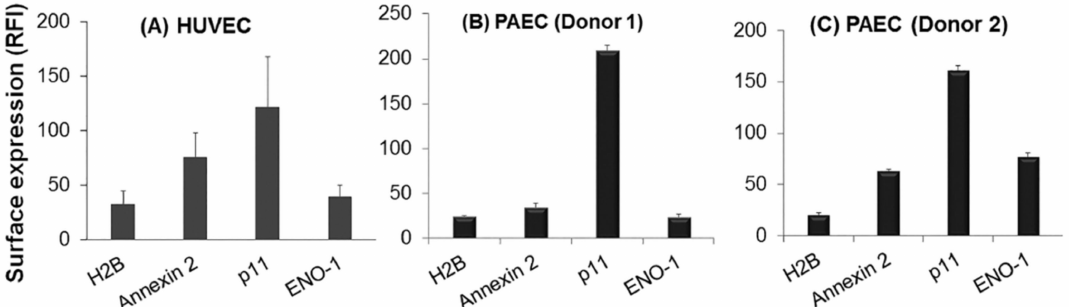
Figure 2. Surface expression of PlgRs in endothelial cells as detected by flow cytometry. H2B, as well as other well-established PlgRs, Annexin 2, p11 and ENO-1, are present on the surface of endothelial cells of venous ( A ) and arterial origin ( B , C ). Data are representative of HUVEC from multiple single donors and single PAEC experiments with at least 3 replicates in each analysis. Values are means ± S.E. mAb to H2B and rabbit anti-Annexin-2, p11 and ENO-1 were detected by flow cytometry on single cell suspensions of viable endothelial cells.